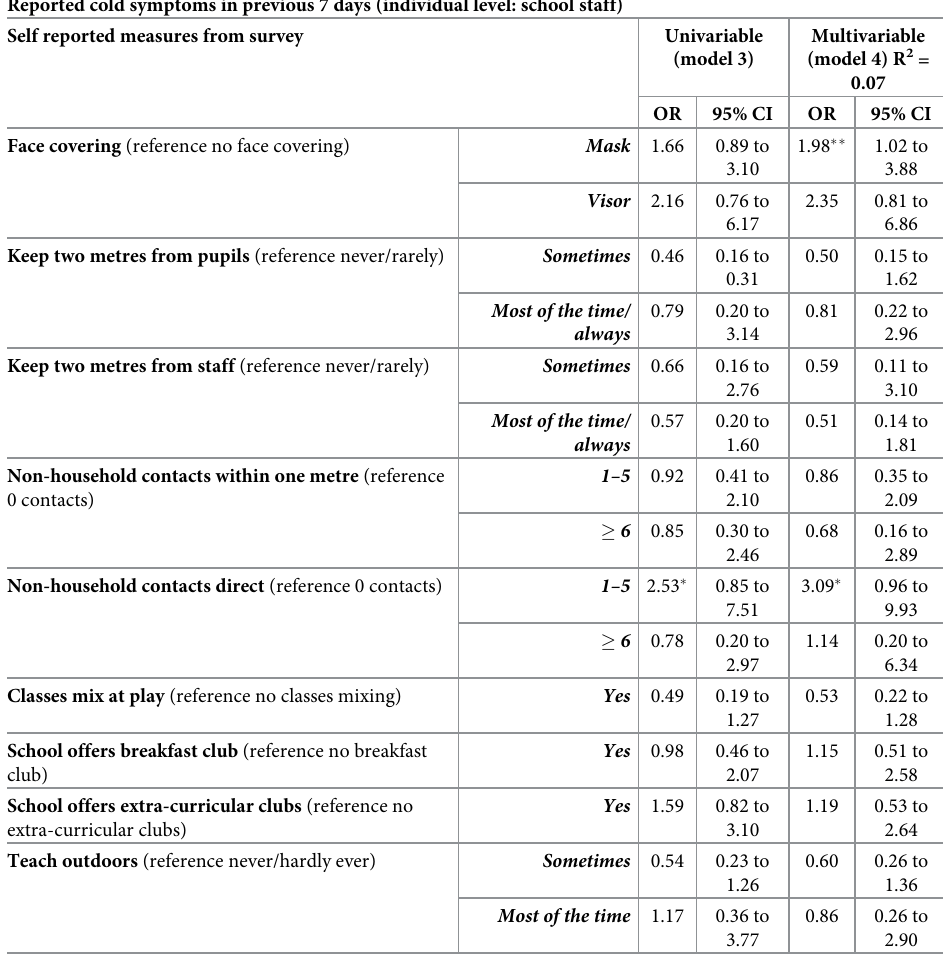
Table 4. Univariable (model 3) and multivariable (model 4) logistic regression models of self-reported school- based mitigation measures (survey) and individual level (school staff) self-reported cold symptoms (survey). Reported cold symptoms in previous 7 days (individual level: school staff) Self reported measures from survey Univariable